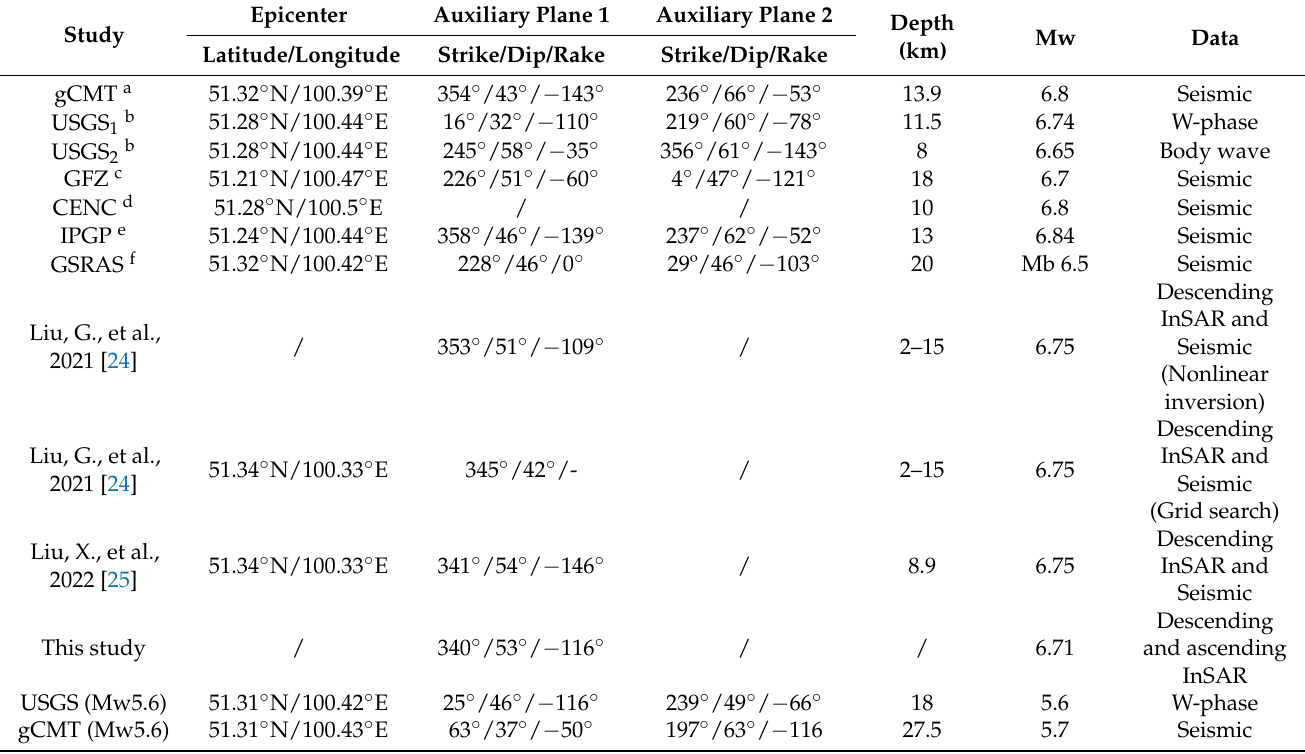
Table 1. Source parameters of the 2021 Mw6.7 Hovsgol earthquake and the Mw5.6 aftershock from different